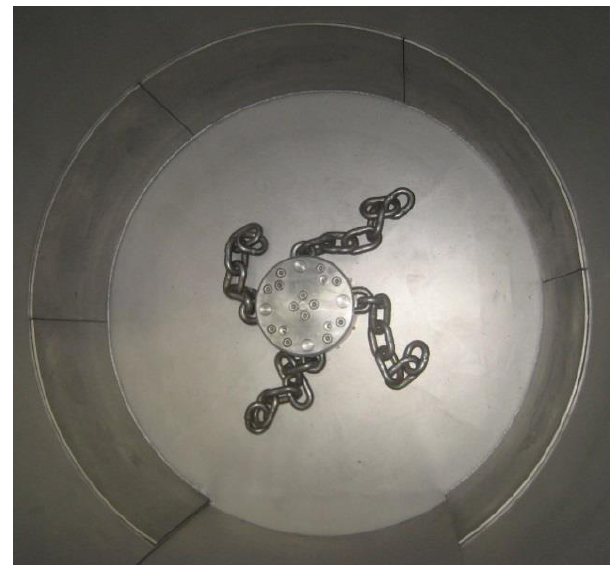
Figure 1. Inside the crusher with crusher head and chain.